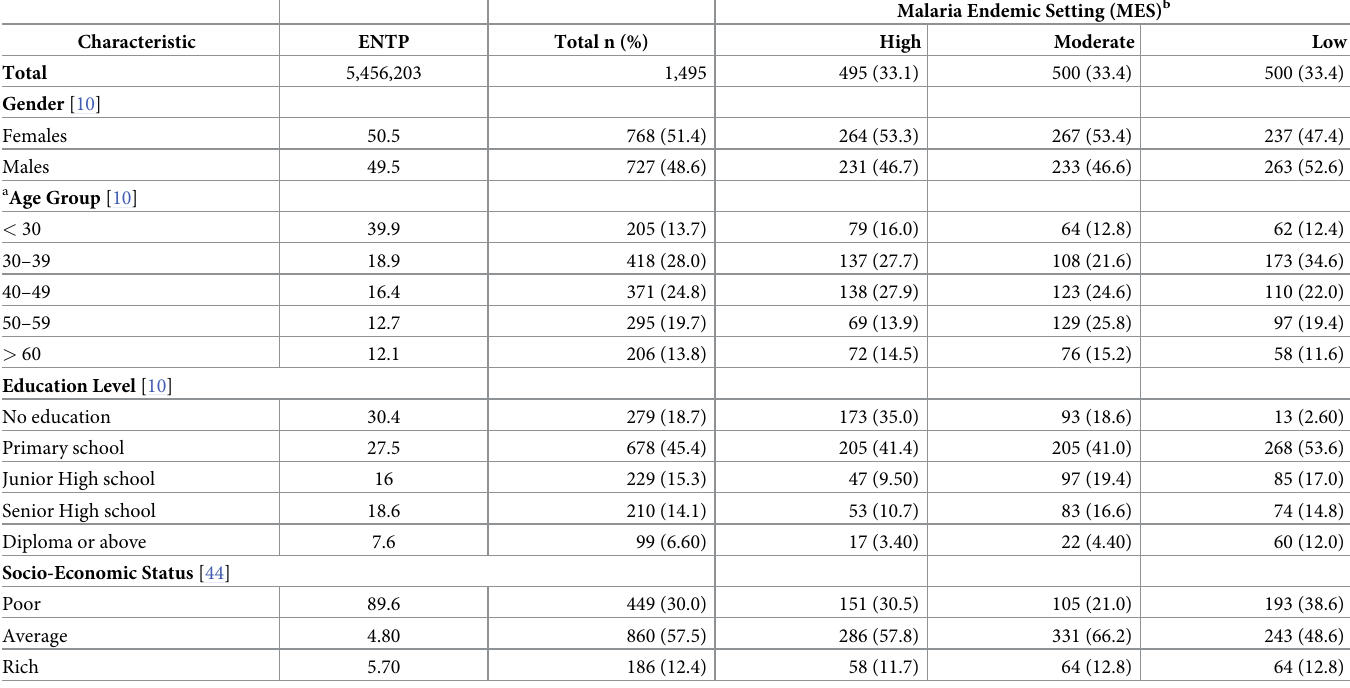
Table 1. Distribution of study participants and participants from a national representative sample in three different MES in the East Nusa Tenggara Province (ENTP), Indonesia.